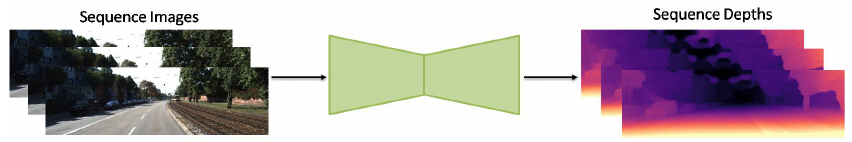
Figure 9. Developed network by Kumar et al.